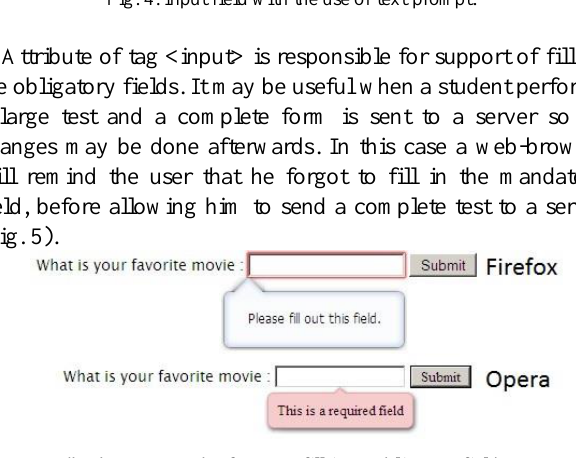
Fig. 4. Input field with the use of text-prompt.